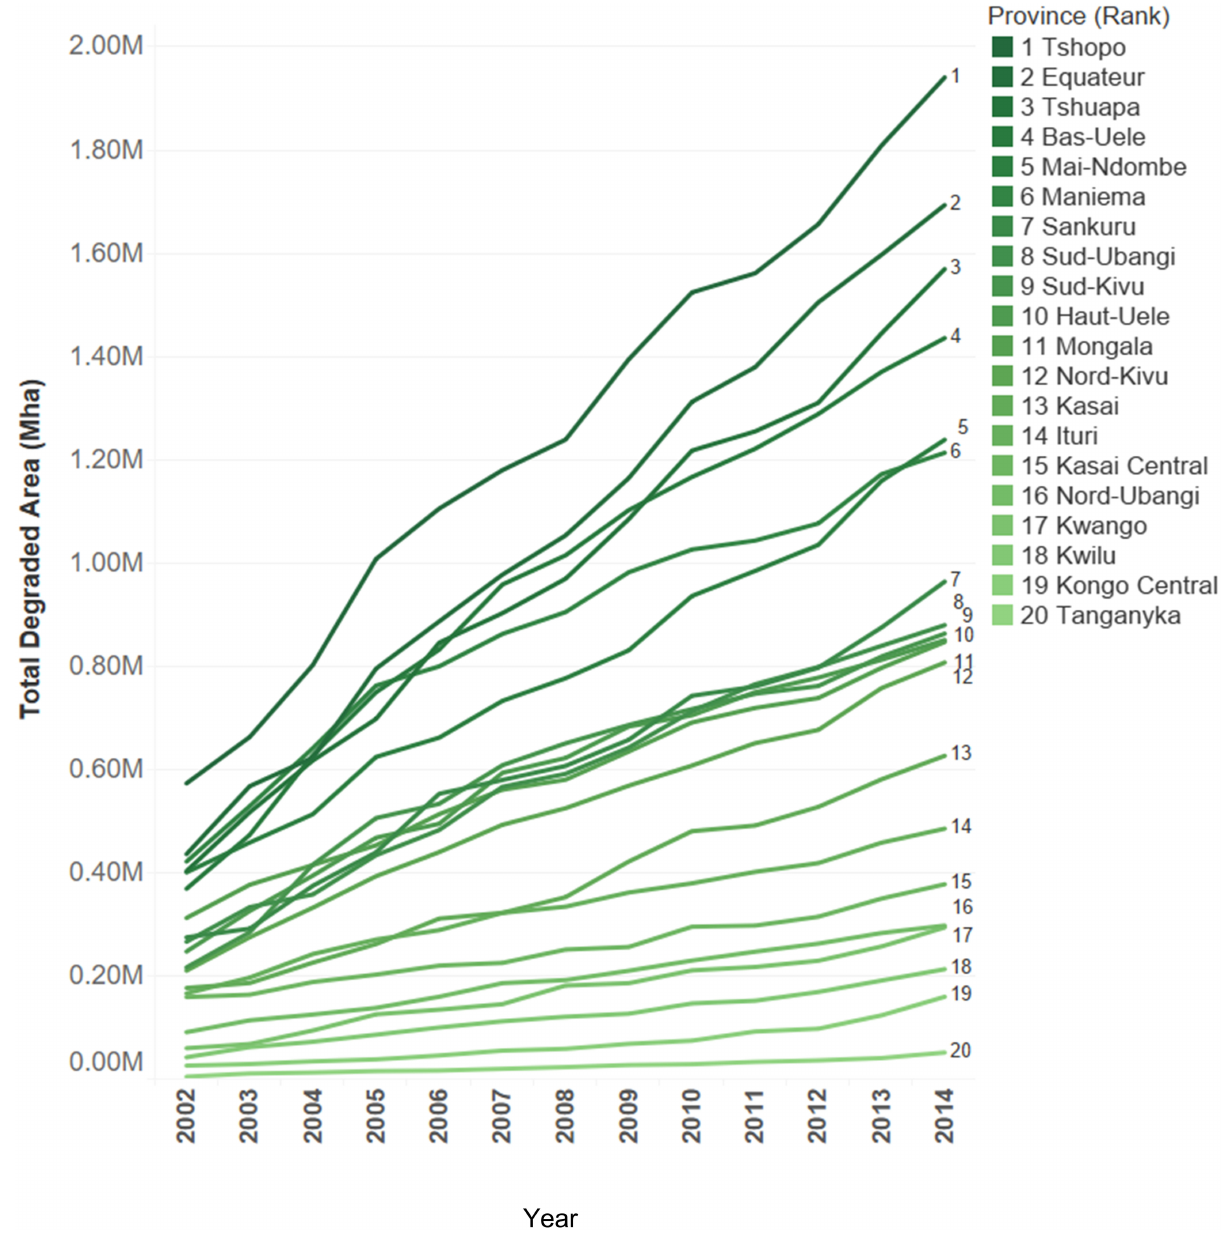
to sum all fire detections in each 3-year time interval. We select all fire detections with a confidence flag > 30 at a resolution of 1 km. Fires are summed over all grid cells in the time